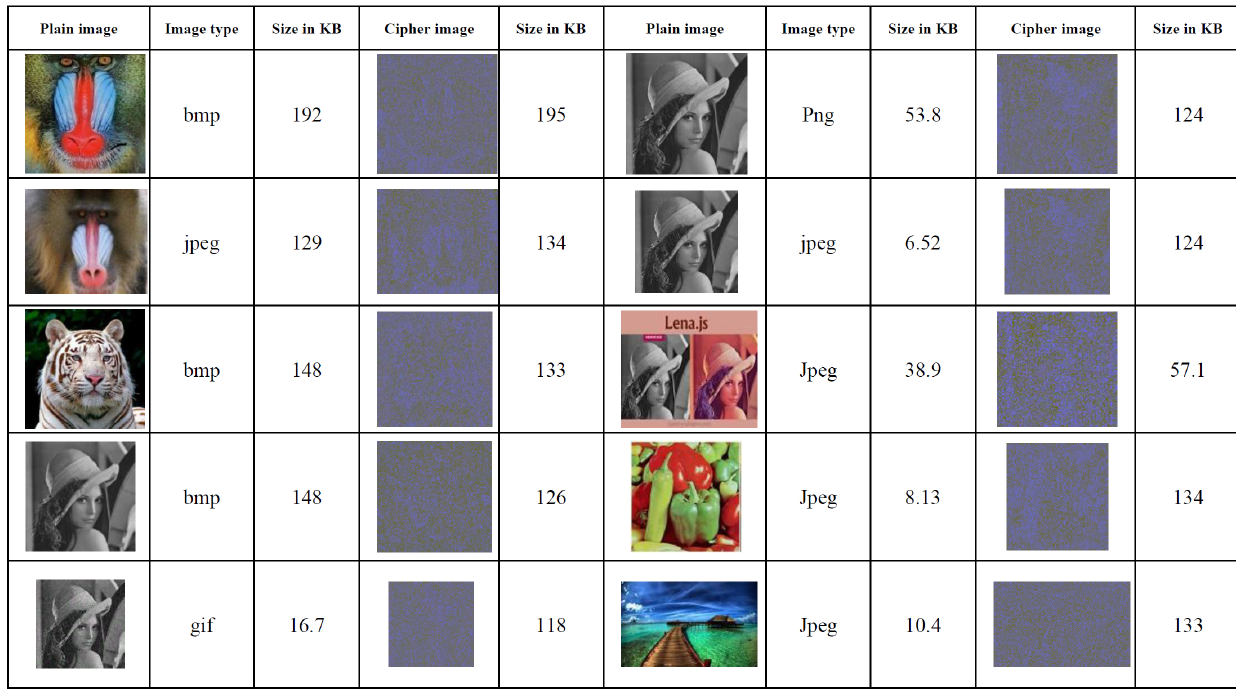
Figure 3. The original images in columns (1st, 6th) and the ciphered images in columns (4th,